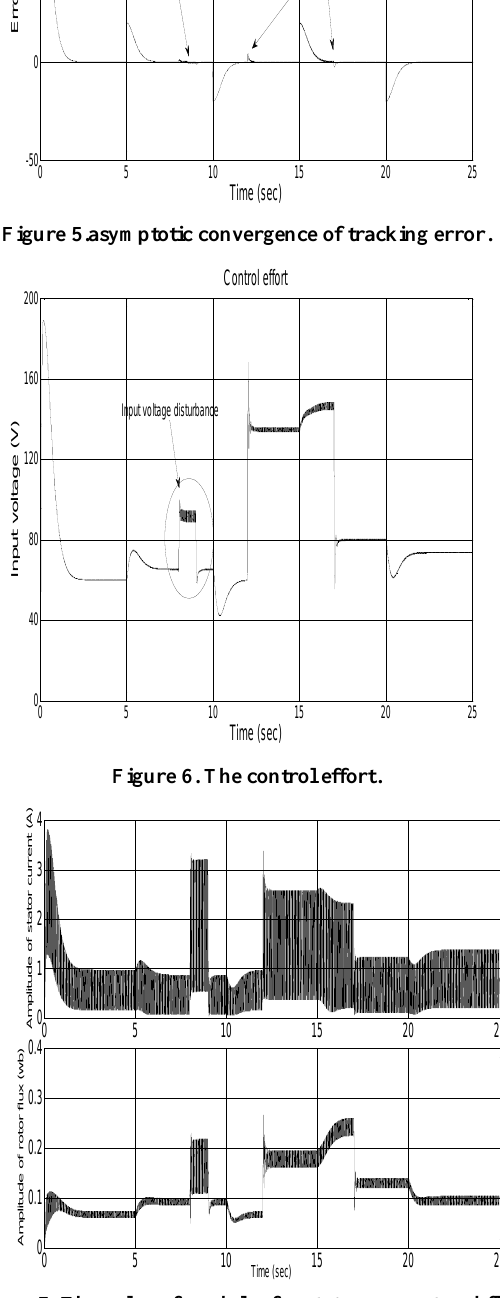
Figure 7. The value of modules for stator current and flux in the control